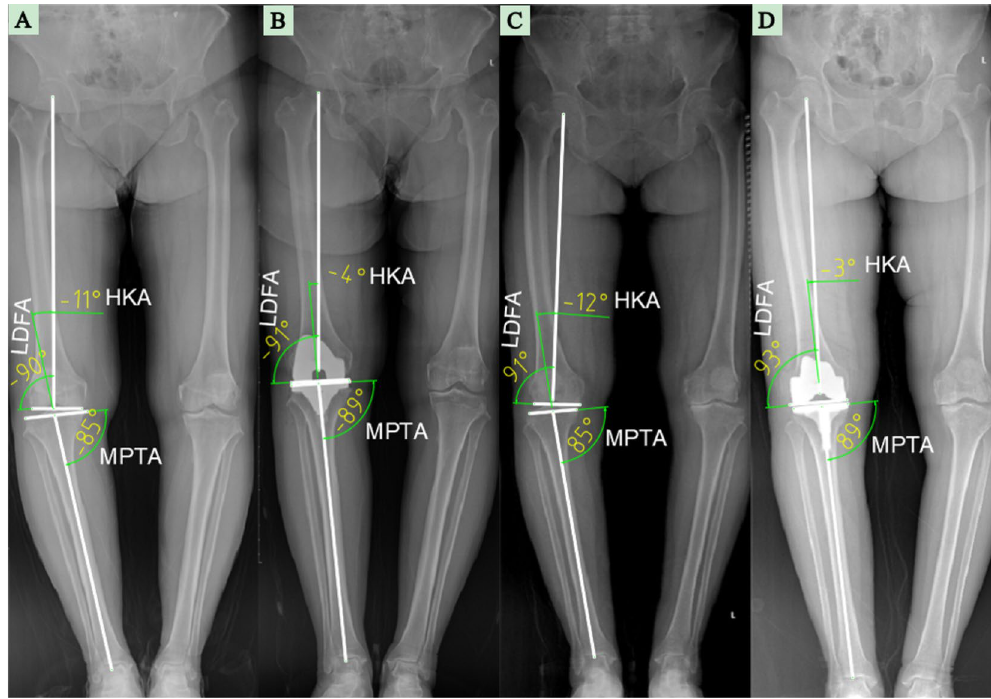
Figure 2. Radiographic measurements of HKA, LDFA and MPTA. Schematic diagrams of preoperative (A) and postoperative (B) standing radiograph for VMA groups, and preoperative (C) and postoperative (D) standing radiograph for NMA